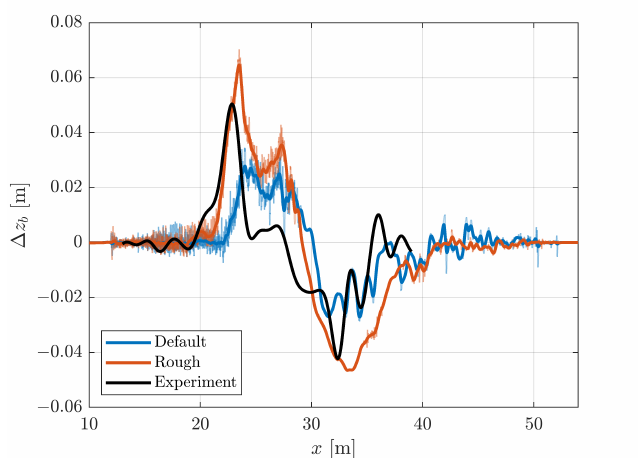
Figure 14. Modelled morphodynamic change when the roughness is increased by a factor of 10 compared to the default case. The thin lines shows the original data and the thick lines shows the same data after a smoothing